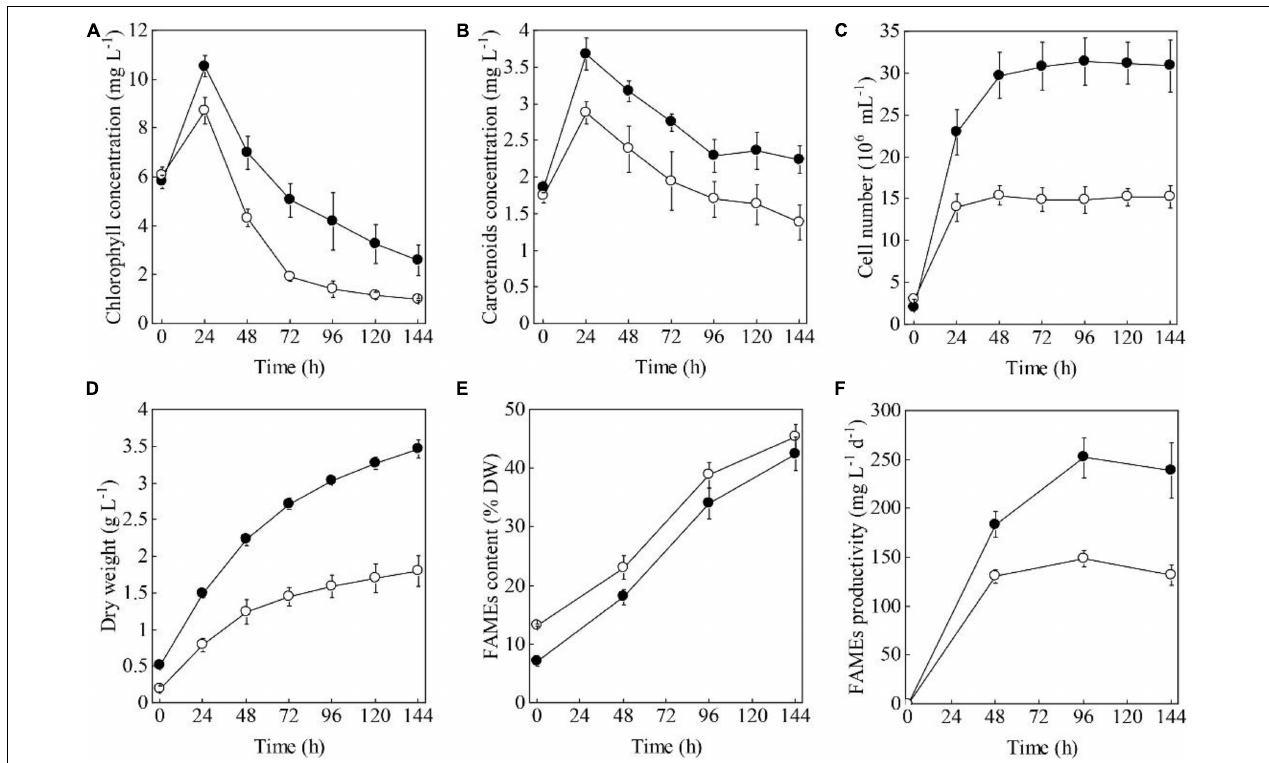
FIGURE 1 | Time evolution of the volumetric chlorophyll concentrations (A) , carotenoid concentrations (B) , cell numbers (C) , dry weights (D) , FAMEs contents (E) , and FAMEs productivities (F) of the heterotrophically (filled cycle)- and photoautotrophically (empty cycle)-grown S. acuminatus cells subjected to the high-light and N-limited conditions. The values represent mean ± S.D. ( n =